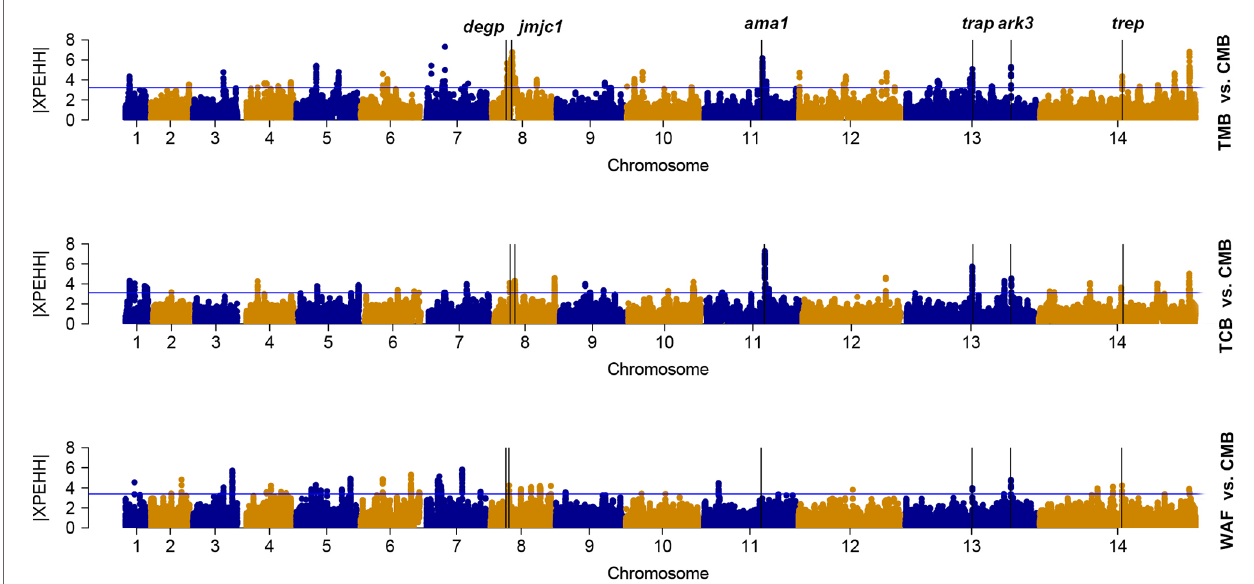
FIGURe 4 | The top |XPEHH| hits for WAF, TCB, and TMB, using CMB as reference. X axis is chromosomes 1 to 14 in alternating colors; y axis is the value of |XPEHH|. The loci above the blue horizontal lines have the top 1% of |XPEHH| values; vertical lines represent the chromosome locations of three genes detected across the isolates from the other three regions (WAF, TCB, and TMB).